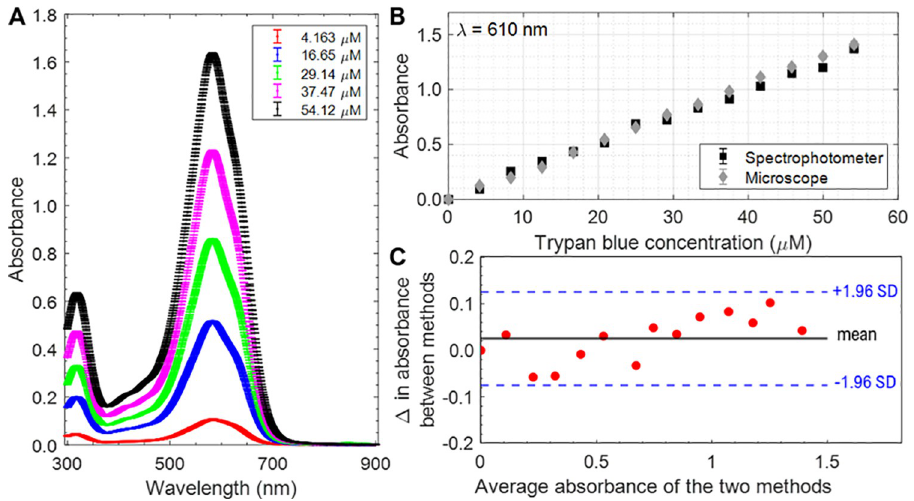
Fig 4. Trypan blue (TB) absorbance measurements. (A) TB absorbance spectrum in Dulbecco’s phosphate-buffered saline (DPBS) measured using a spectrophotometer. Each data point is an average of three replicates (3 readings of the same cuvette) and error bars are standard deviation (SD). (B) TB absorbance at λ = 610 nm measured using a spectrophotometer (black squares) and absorbance microscopy (gray diamonds). The error bars represent SD (3 readings of the same cuvette). (C) Bland–Altman plot for assessing agreement between two methods presented in panel (B), where the solid black line denotes the bias between the mean differences ( Δ ) and dashed blue lines indicate ± 1.96 SD, which cover 95% of the